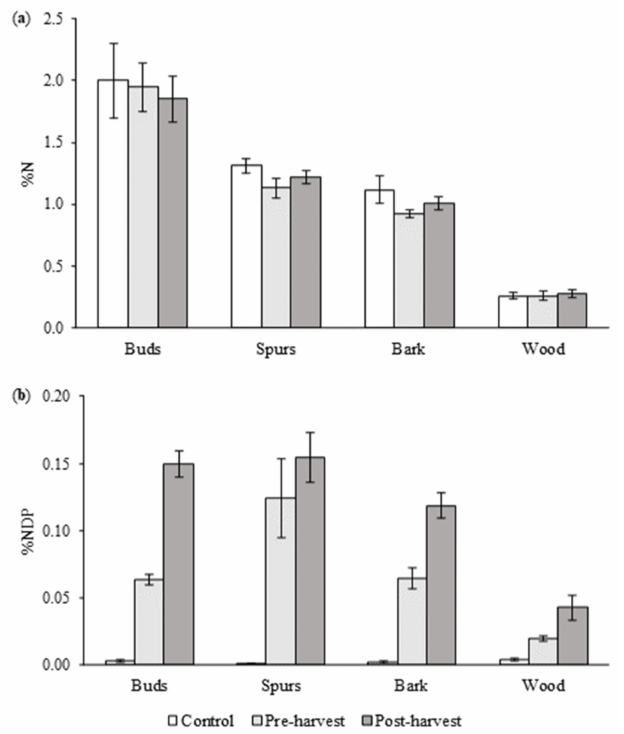
Figure 2. ( a ) Total N content (%N) and ( b ) N derived from L-proline (%NDP) of branch tissues at dormancy. Error bars represent ± SEM (n =